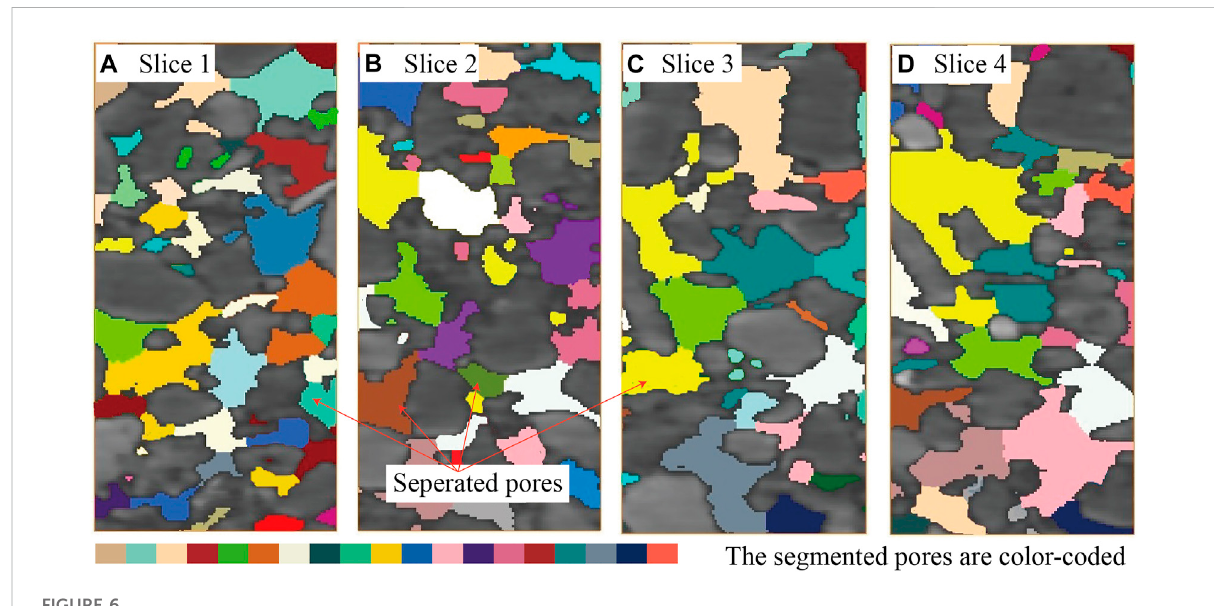
Pores segmented by the watershed algorithm.